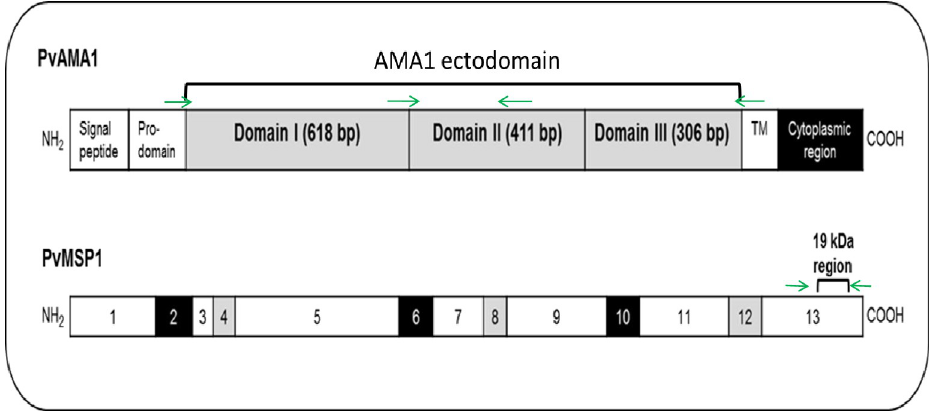
Fig 1. Pvama1 and Pvmsp1 region targeted for sequencing. Schematic diagram of the structure of Pvama1 and the 19 Pvmsp1 19 region studied. Primer location is indicated with green